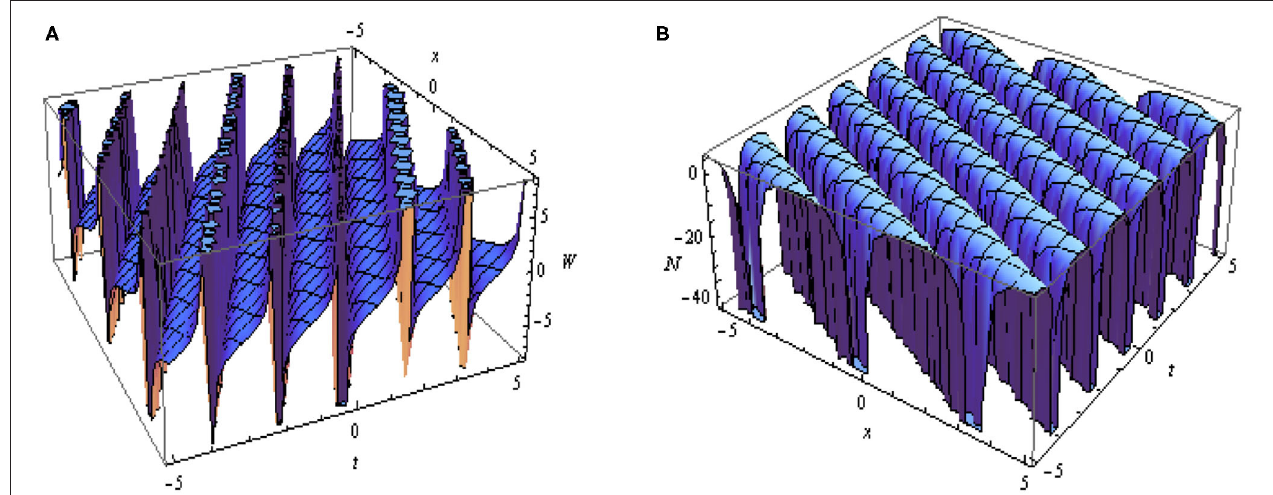
W ( x , t ) N ( x , t ) and given in Equations (13) and (14) with values of parameters as l | | | |